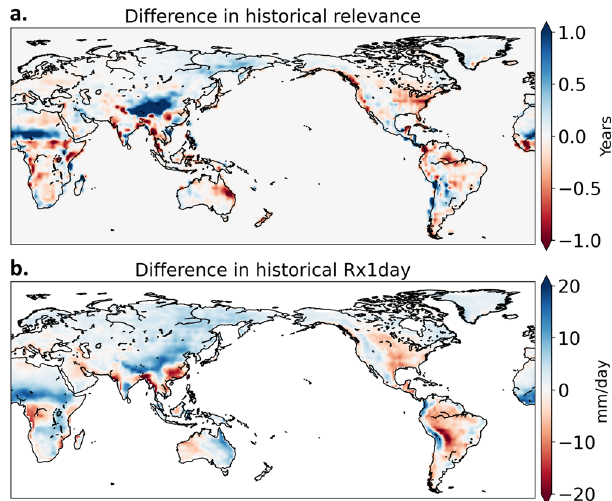
Fig. 3 Differences between subsets of models with high and low predicted years by the neural network during the baseline period (1920 – 1949). a , b The difference in their relevance maps ( a ) and annual maximum daily precipitation (Rx1day) ( b ) between the four models with the highest mean predicted year and the four models with the lowest mean predicted year (as shown in Fig. 1a, b). Relevance is the contribution of each grid value to the neural network ’ s decision, obtained using layer-wise relevance propagation (see “ Methods ”